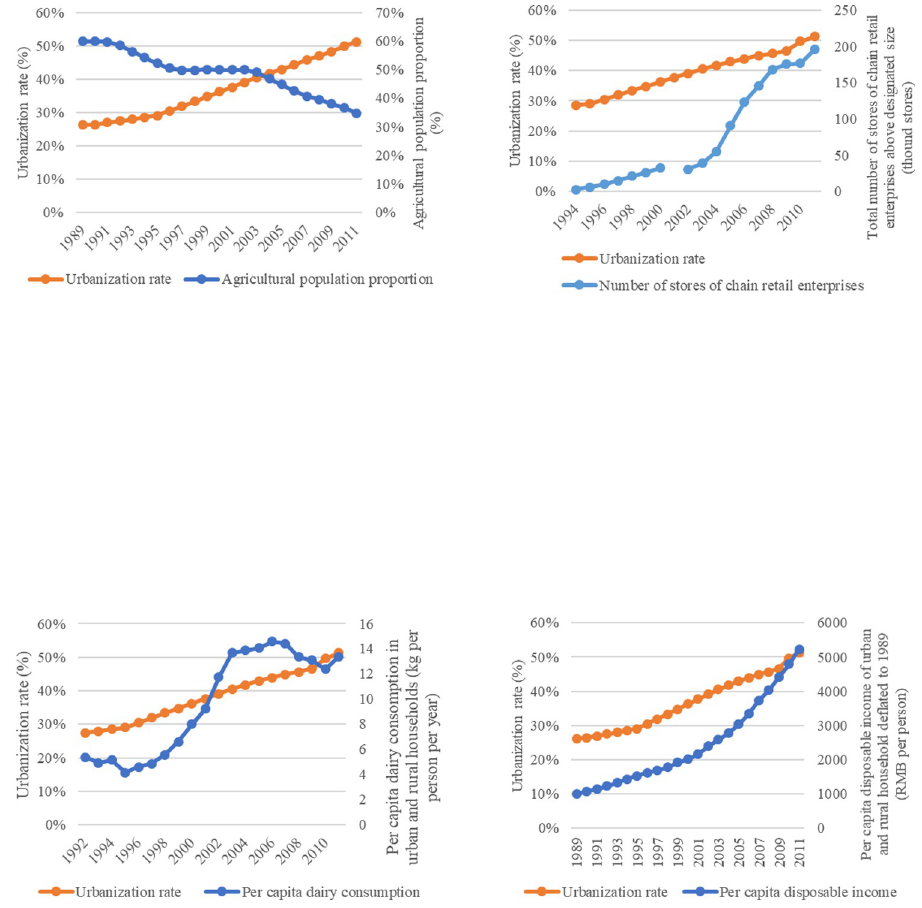
Fig 1. Urbanization and statistics related to residents’ consumption of dairy products. Note: Data source: China Statistical Yearbook , China Dairy Yearbook . The chain retail enterprises above designated size contains chain retail enterprises with 60 employees or more and annual sales of 5 million RMB or more.